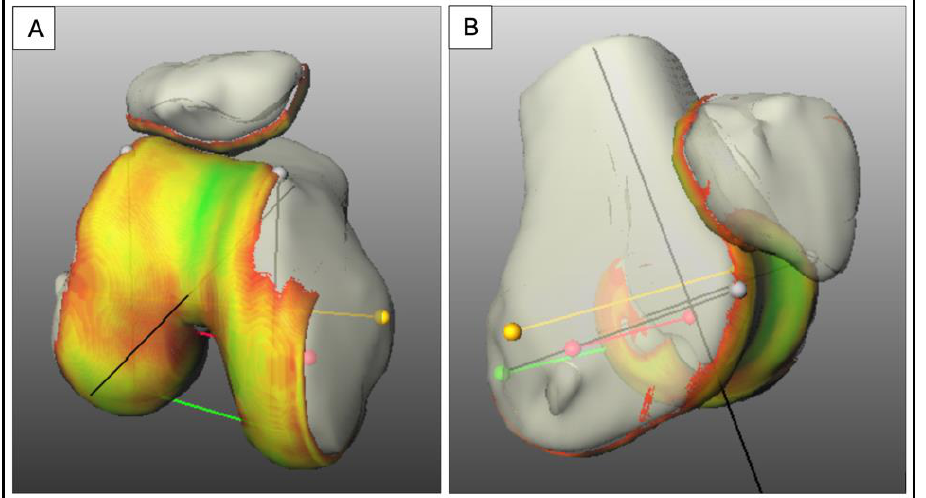
Figure 3. 3D mesh of bone and cartilage structures to demonstrate the cartilage contact area ( A , B ), which serves as a basic matrix for the semi-automated determination of the kinematic parameters, yellow line: TEA (transepicondylar axis), red line: TCA (transcondylar axis), green line: PCA (posterocondylar axis). The color code shows the cartilage surface thickness. Green (5 mm layer thickness) over the gradient to yellow (2.5 mm layer thickness) and to red (1 mm layer thickness). The image registration was performed for each bone individually, optimizing a nor- malized gradient fields (NGF) distance measure on the MRI data, restricted to a region around the respective bone. Based on the assumption that the bones do not deform signifi- cantly, the result of this bone alignment is individual rigid transformation matrices for all bones and thus articulated mesh models that were then used to analyze the CCA and the patellofemoral